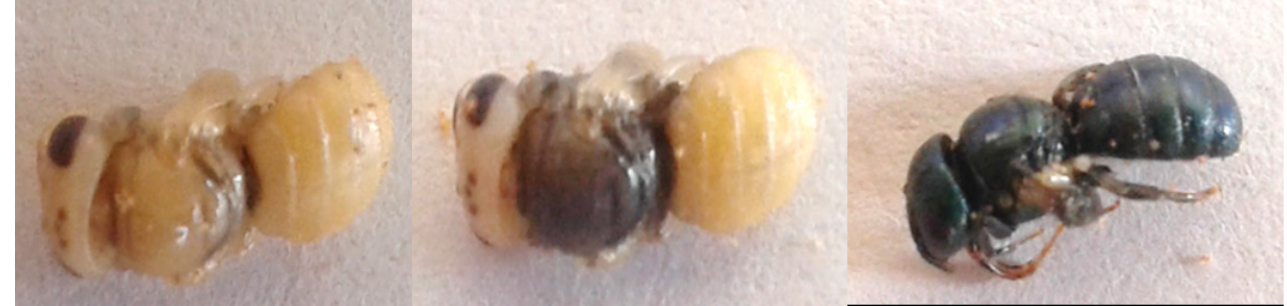
Fig 4. Adult of Ceratina binghami at different stages of body